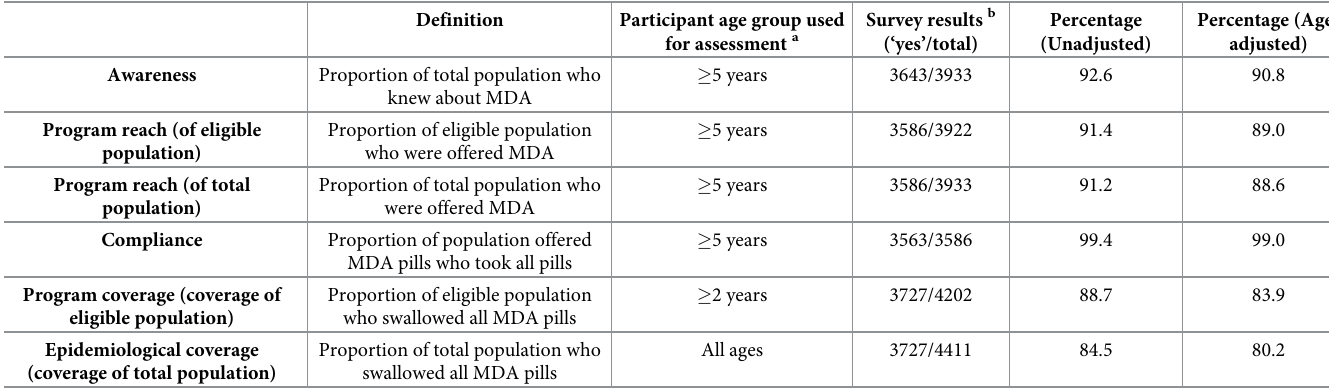
Table 2. MDA awareness, reach, compliance and coverage.